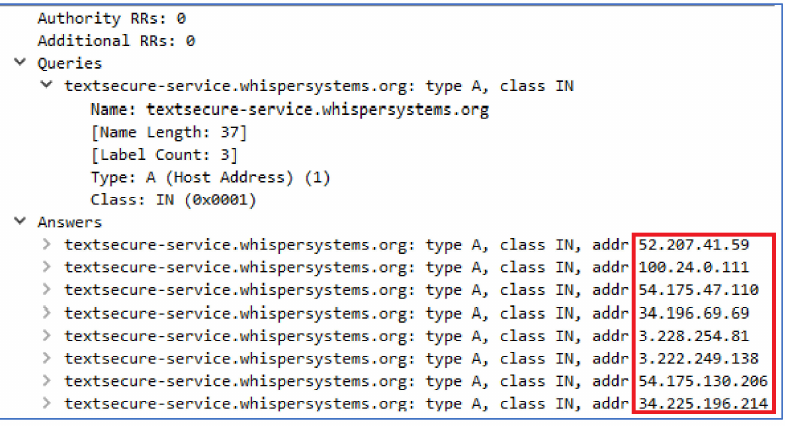
Figure 18. Type A Server